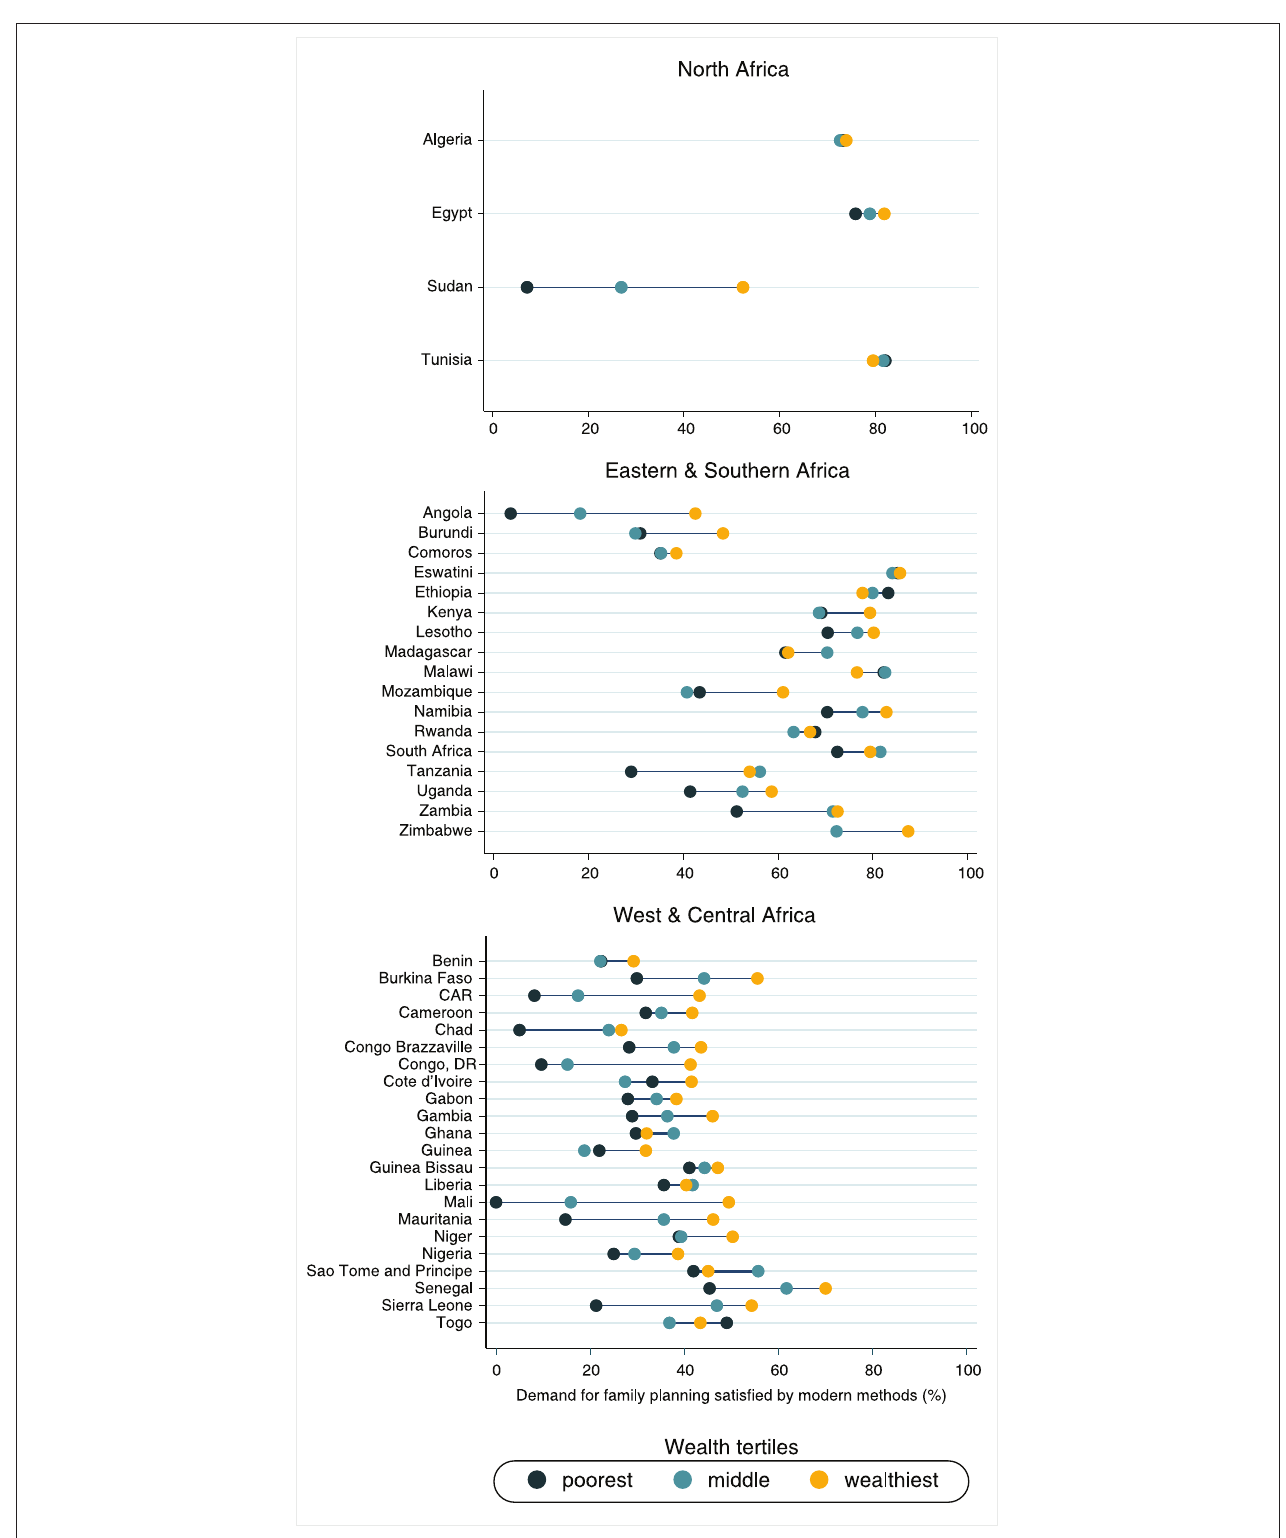
FIGURE 4 | Demand for family planning satisfied by modern methods according to world region and wealth groups.